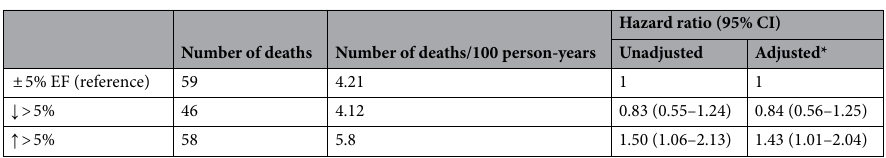
Table 6. Cox proportional hazard model of EF trend (n = 936). *Adjusted for age, gender and initial EF.